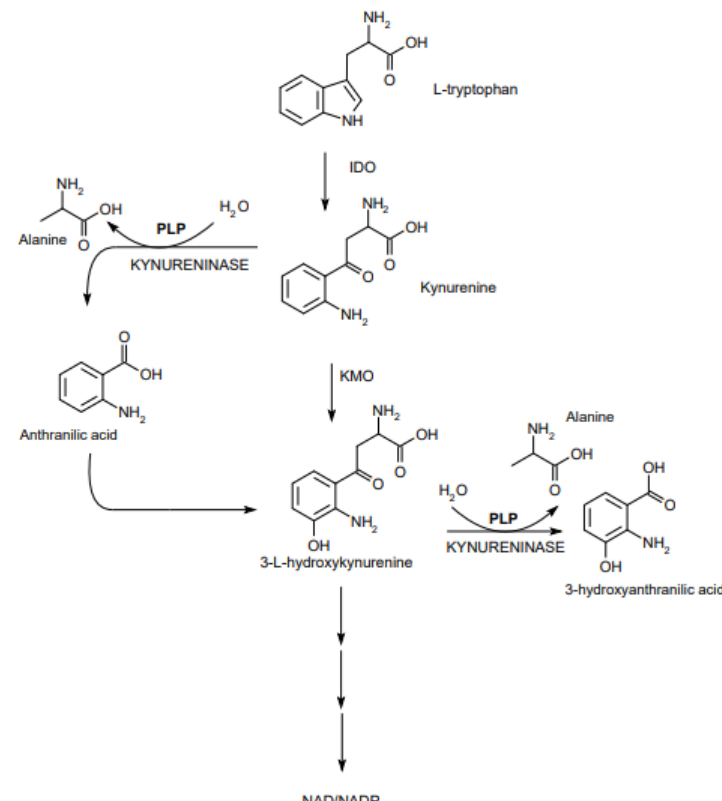
Figure 3. A role of PLP in the kynurenine pathway.